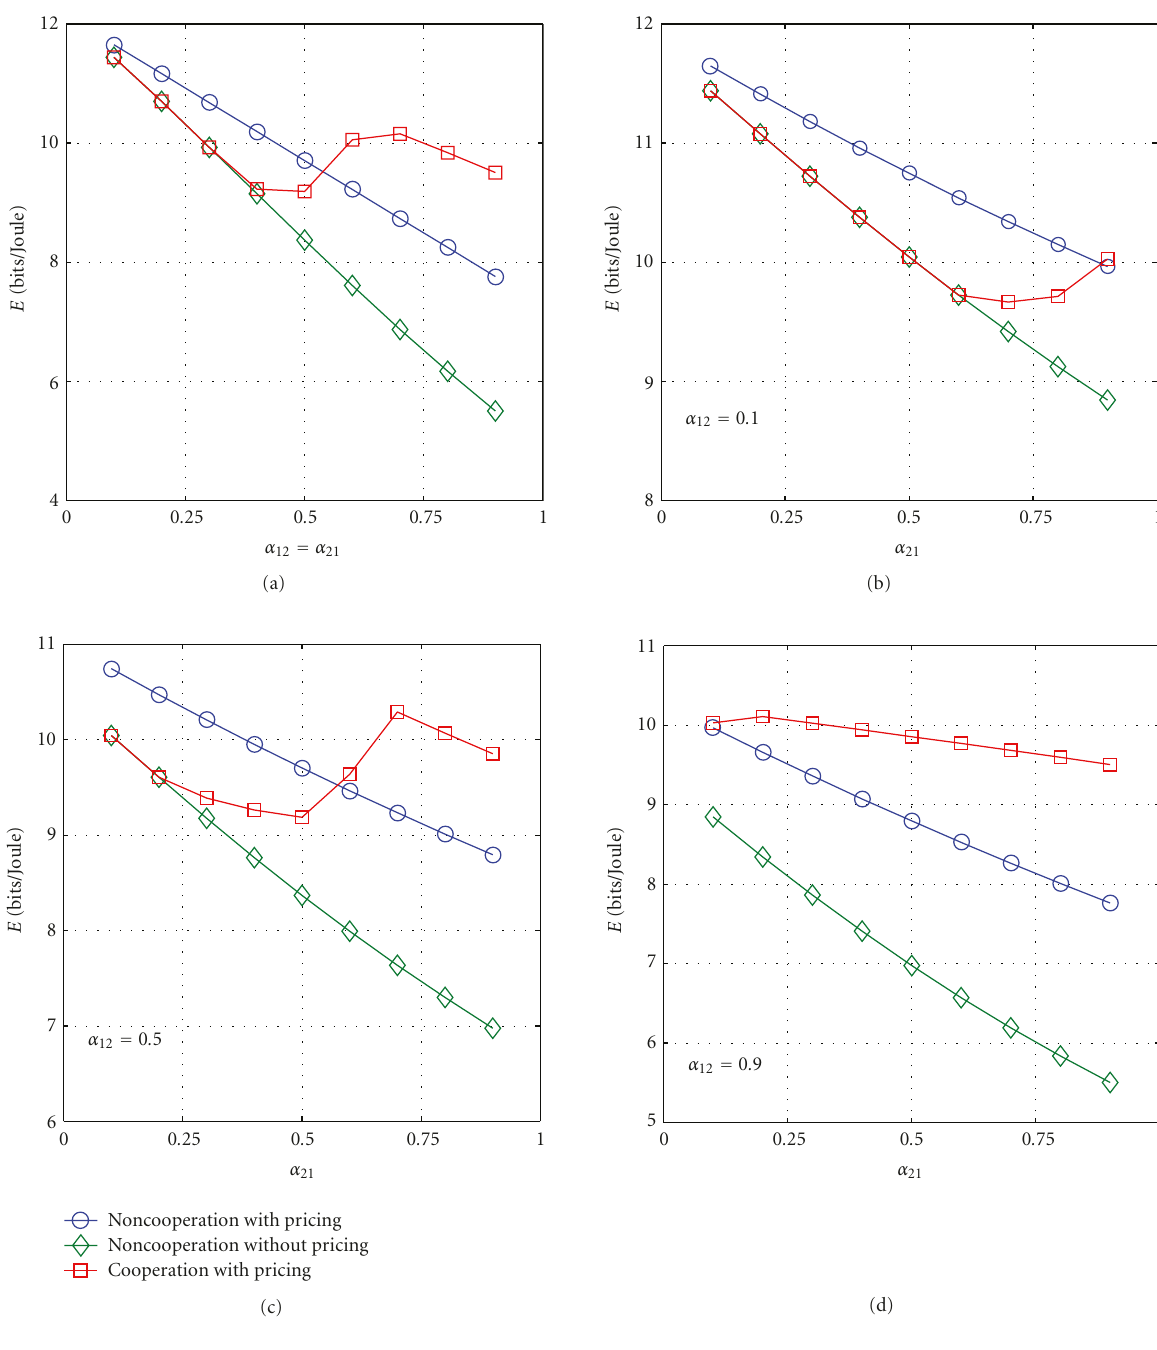
Figure 4: Comparison of energy-e ffi ciency E with various CCCs. The noncooperative case with pricing (S1) is plotted with blue circles, the noncooperative case without pricing (S2) with green diamonds, and the cooperative case with pricing (S3) with red